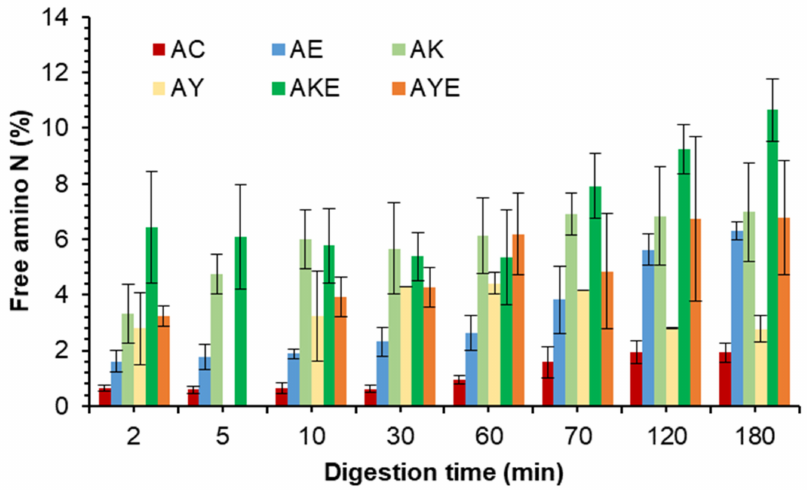
Figure 15. Free amino N (%) release during simulated gastro-small intestinal digestion of almonds in the presence or absence of Hayward or SunGold kiwifruit extract. AC, almond (A) control without any digestive enzymes; AK/AY, with added green/gold kiwifruit extract but no digestive enzymes; AE, with digestive enzymes but no added kiwifruit extract; AKE/AYE, with both digestive enzymes and green/gold kiwifruit extract. Numbers 2, 10, 30 and 60 are the gastric digestion time following 2 min of oral digestion. Numbers 70, 120 and 180 are the total digestion times in oral-gastro-small intestinal digestion (including the first 60 min of gastric